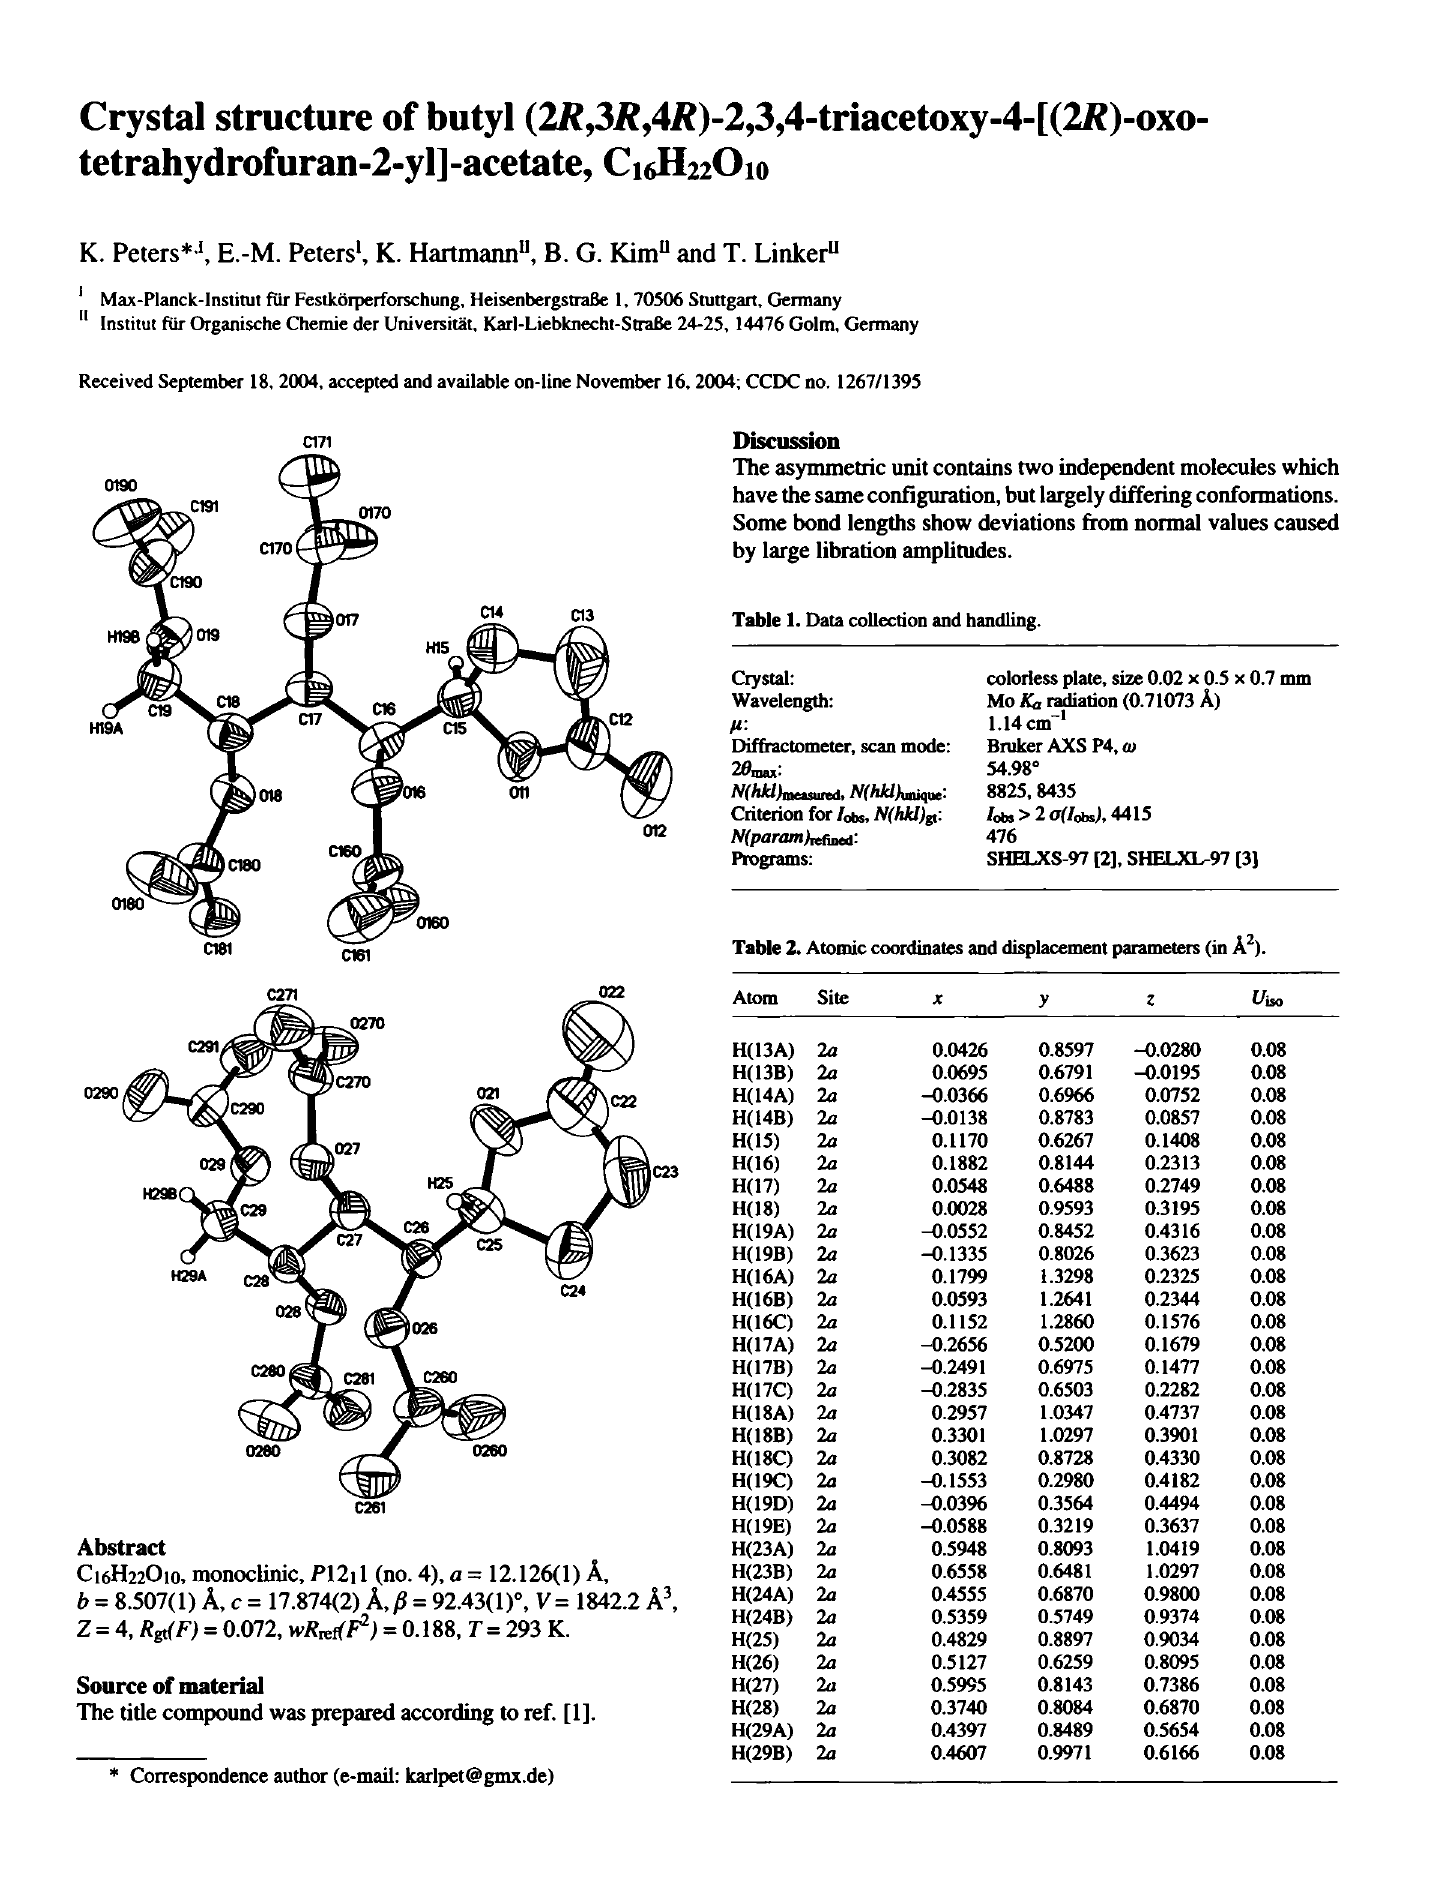
Table 1. Data collection and handling.